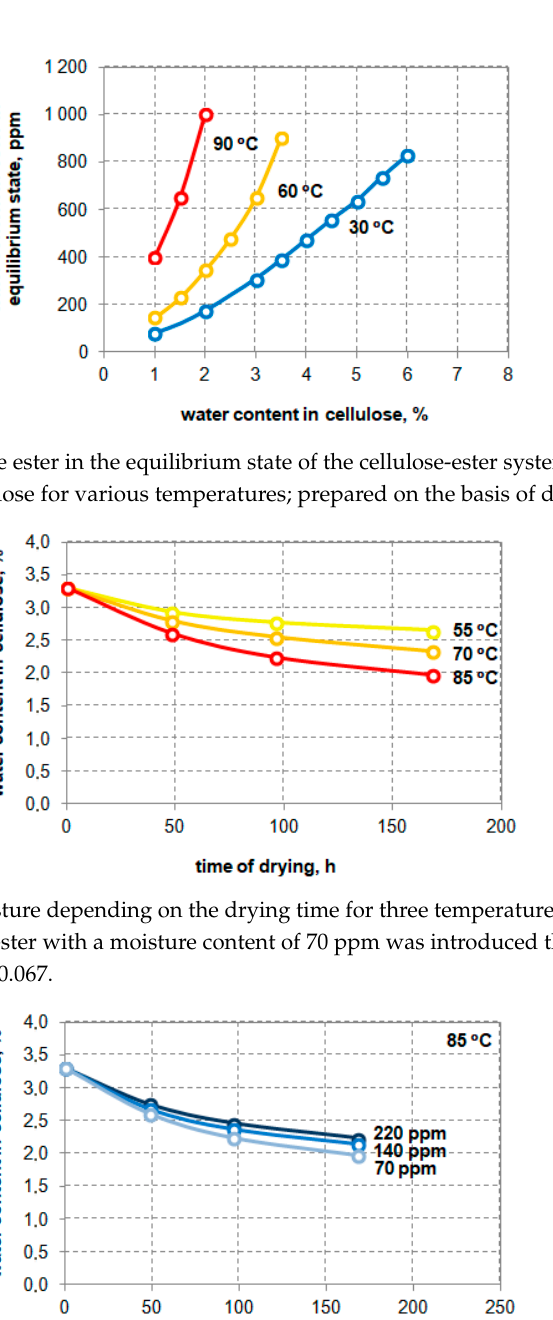
introduced ester; initial moisture of cellulose 2%, 3%, and 4%, insulation thickness 3 mm, mass ratio